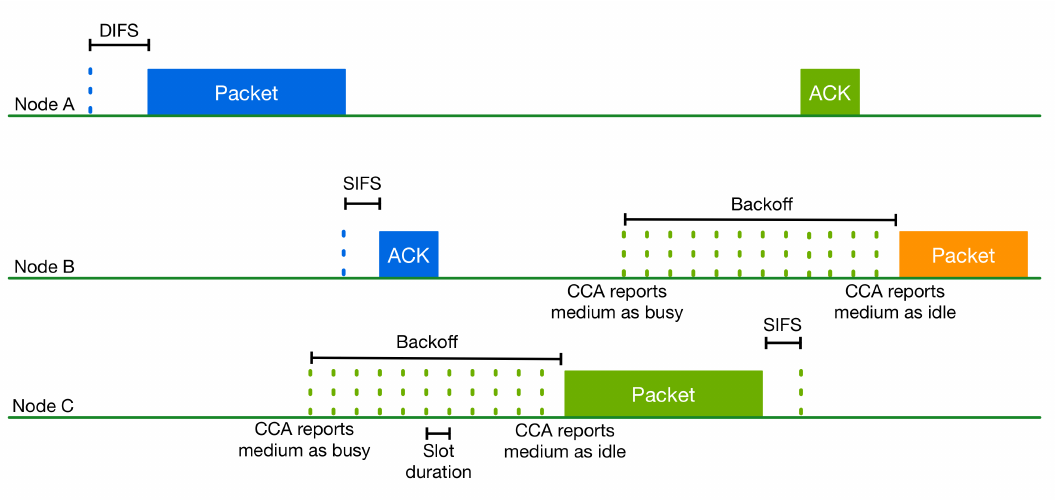
Figure 4. The 802.11 CSMA/CA